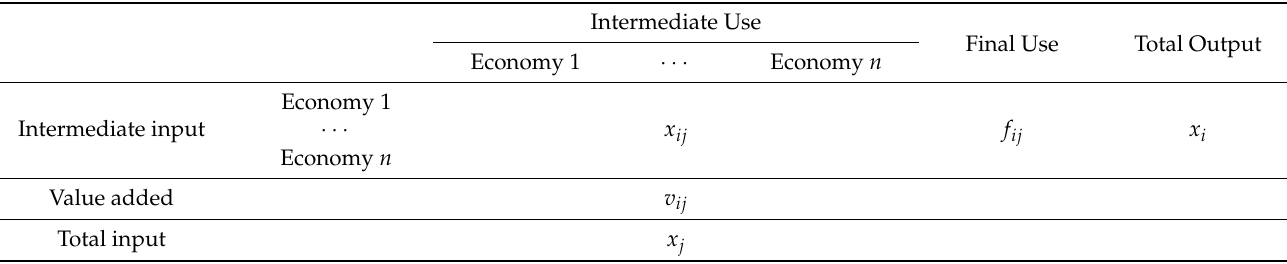
Table 2. Fundamental structure of MRIO